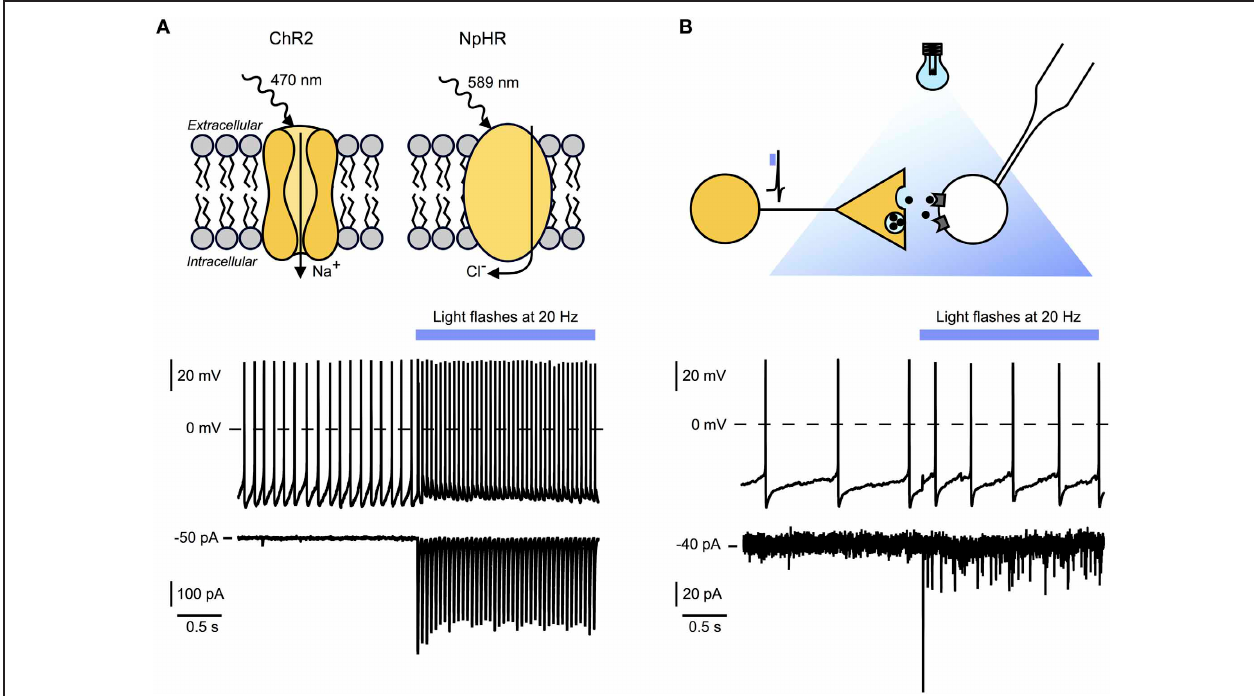
stimulation. (B) Top panel: Experimental scheme illustrating experimental setup for ChR2-assisted circuit mapping. Yellow neuron, expressing ChR2, will release signaling molecules after optical stimulation. Time locked responses in postsynaptic cell (white) can be recorded using whole-cell patch-clamping. In combination with pharmacological blockade this technique allows the determination of receptors and transmitters involved. Bottom and middle panel: Recordings of a histamine neuron responding to 20Hz optogenetic stimulation of hcrt/orx fibers (blue bar). Bottom: Voltage-clamp recording showing time locked postsynaptic currents evoked by transmitters release from hcrt/orx terminals in response to blue light flashes. Failures indicate that not all action potentials lead to vesicle release. Middle: Current-clamp recording with baseline firing rate and increased action potential firing during optical stimulation of hcrt/orx